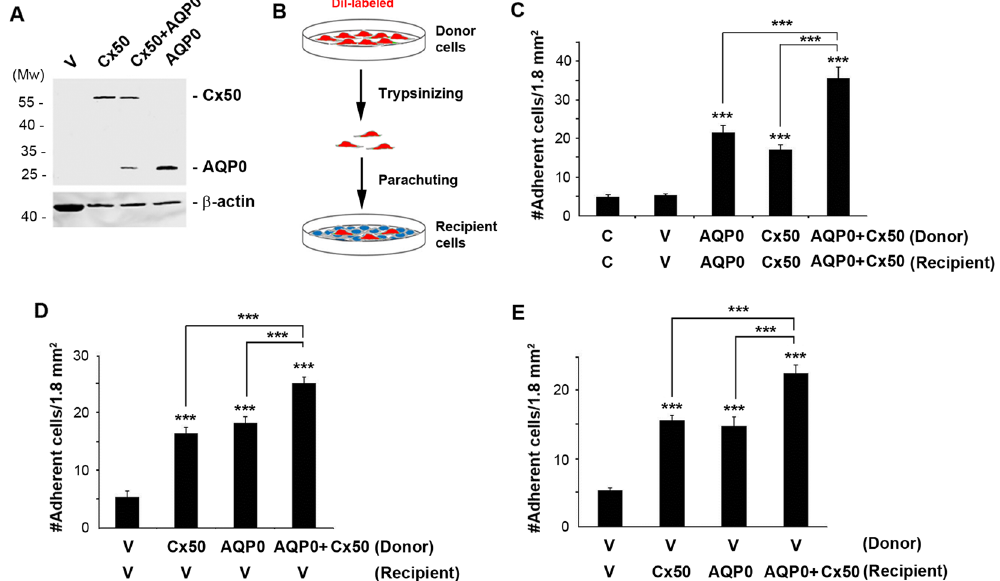
Figure 1. Cx50 increases cell-cell adhesion and enhances the adhesive capability of AQP0. ( A ) Crude membrane extracts were prepared from CEF cells infected with high titer RCAS(A) retroviral vehicle (V) or recombinant RCAS(A) retroviruses containing Cx50, AQP0 or co-infected with both Cx50 and AQP0 and were immunoblotted with anti-Flag or β -actin antibody. ( B ) The diagram illustrates cell adhesion assay via “parachuting” Dil-fluorescence-labeled donor cells onto the confluent recipient cells. ( C–E ) High titer recombinant retroviruses containing RCAS(A) vehicle (V), Cx50 or AQP0 were used to infect CEF cells.